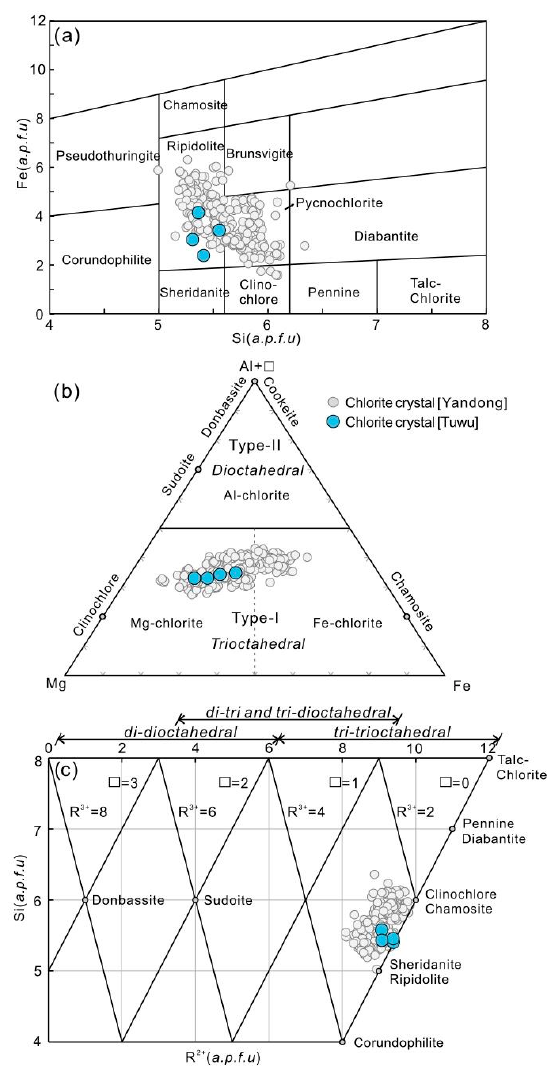
Figure 9. ( a ) Si versus Fe diagram of chlorite (after [80]). ( b ) (Al + □ )–Mg–Fe plot (after [81]). ( c ) R 2+ versus Si (a.p.f.u) plot (after [82]).